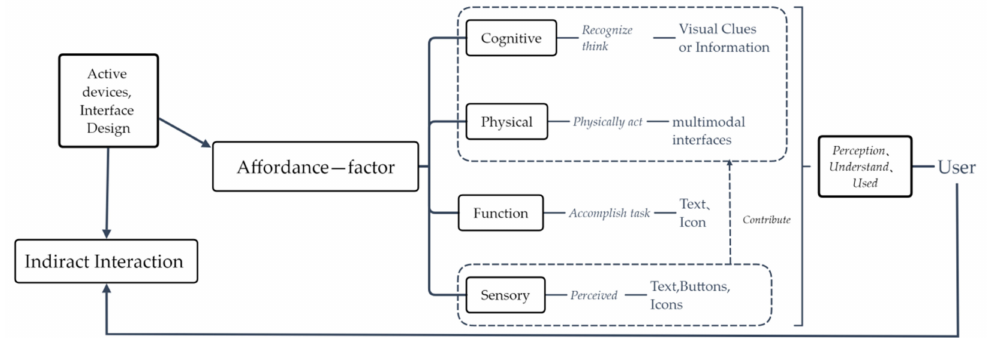
Figure 1. Conceptual diagram of interaction design pertaining to the affordance